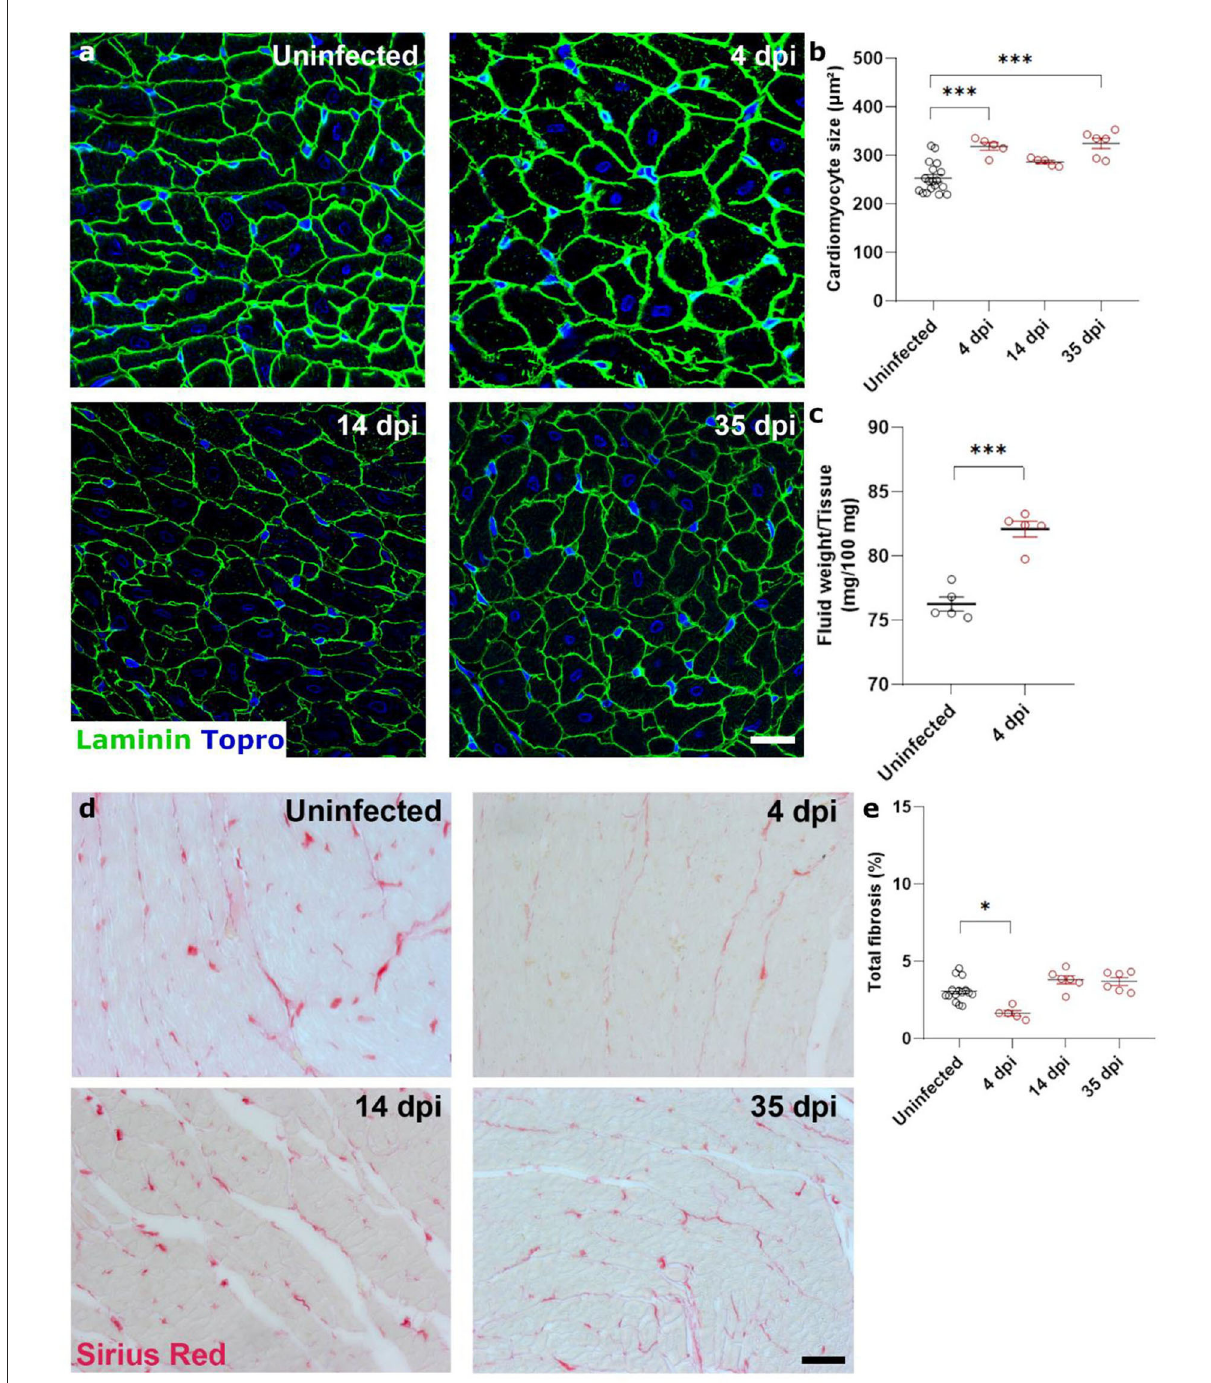
FIGURE2 SARS-CoV-2 infected hamsters present with rapid and consistent cardiomyocyte swelling in the absence of interstitial fibrosis. Twelve week old hamsters were infected with SARS-CoV-2 virus and sacrificed 4 days post infection, at the peak of viral load, at 14 dpi, and at 35 dpi. (a) Left ventricle heart sections of age-matched control and infected hamsters were stained for laminin and Topro3 to quantify cardiomyocyte cell size (b) . (c) Cardiac wet weight and dry weight were compared to indicate cardiac oedema at 4 dpi. (d) Left ventricle heart sections of age-matched control and infected hamsters were stained with Picro Sirius Red to analyse cardiac fibrosis (e) . Values are presented as mean ± SEM with n = 18 (uninfected) and 5-6 (SARS-CoV-2 infected hamsters). All data were analyzed using a one-way ANOVA followed by a Dunnett’s multiple comparison test with * p < 0.05, ** p < 0.01, *** p < 0.001 comparing 14 dpi and 35 dpi hamsters to uninfected hamsters. Scalebar represents 20 µ m (a) and 50 µ m (d)